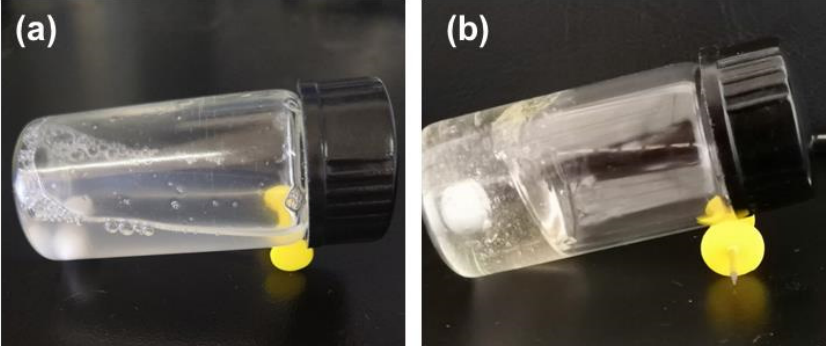
Figure 1. The MC solution before ( a ) and after ( b ) HRP-catalysed crosslinking. The concentrations of MC, HRP, and H 2 O 2 are 10 mg mL − 1 , 5 U mL − 1 , and 0.8 mM.